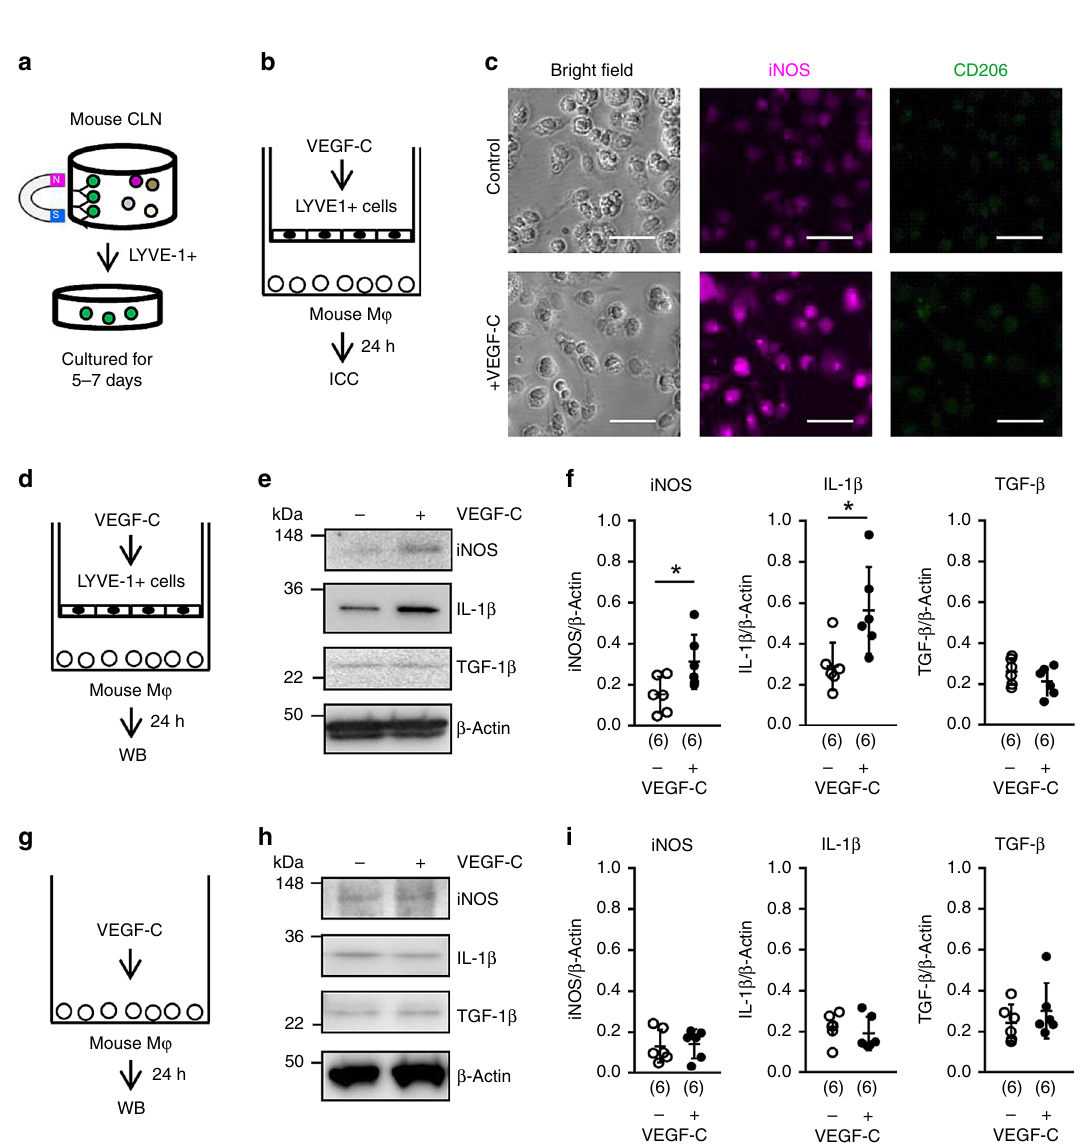
Fig. 5 Activated lymphatic endothelium upregulates pro-in fl ammatory macrophages in vitro: a LYVE-1 antibody-conjugated magnetic beads were used for lymphatic endothelial isolation using CLNs isolated from 4 mice. b VEGFR3 was activated by adding VEGF-C (10 ng/ml) to mouse CLN lymphatic endothelial cells for 24h, then cells were co-cultured with mouse peritoneal macrophages for another 24h and analyzed by immunostaining. c Immunostaining showed that the expression of iNOS (M1-like) was upregulated, but CD206 (M2-like) expression did not change. Scale: 50nm. d – f Western blot con fi rmed that iNOS and IL-1 β were upregulated, but TGF- β did not change. * P < 0.05, unpaired t-test. g – i VEGF-C (10ng/mL) was directly added to macrophages for 24h. Western blot con fi rmed that VEGF-C itself did not change macrophage iNOS, IL-1 β , and TGF- β expressions ( n = 6 biologically independent cells, n = 3 biologically independent experiments), unpaired t -test. All values are mean + / − SD.